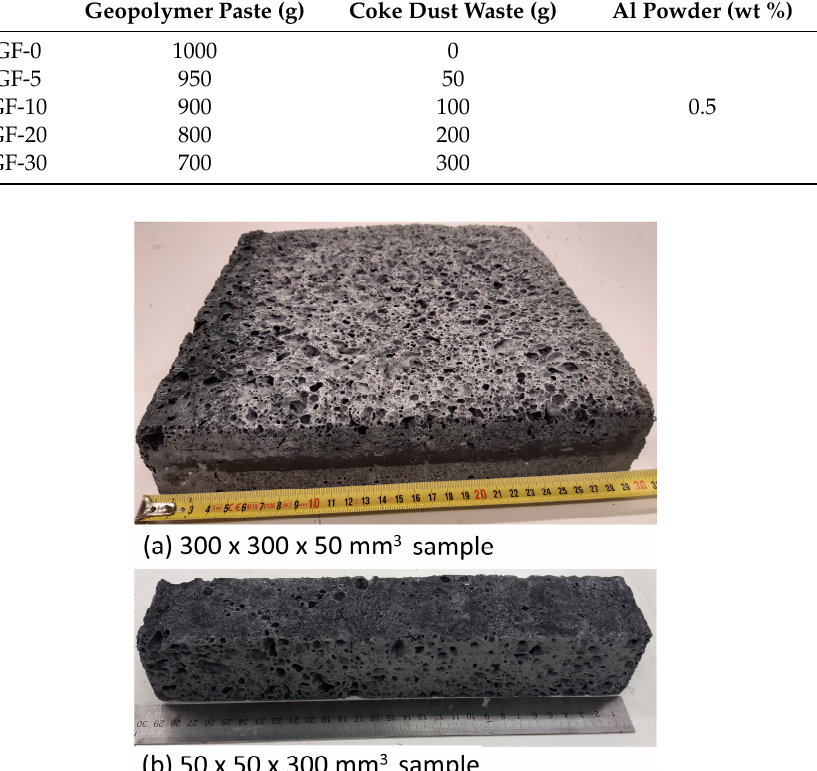
Figure 3. The sizes of the foam geopolymer samples prepared for testing: ( a ) samples for thermal conductivity test; ( b ) samples for flexural strength and compressive strength test.